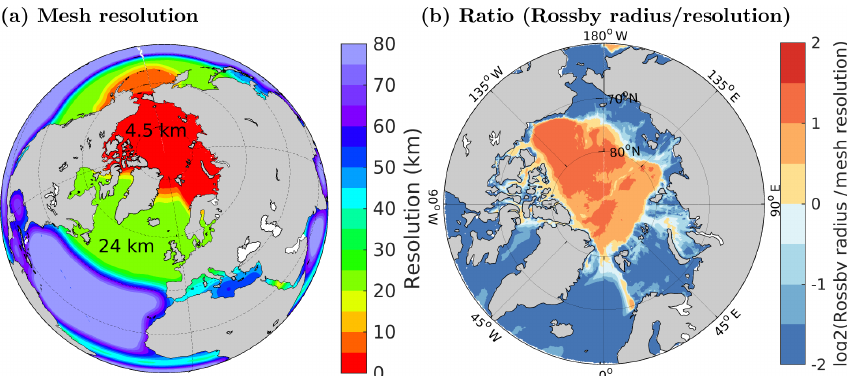
Figure 2. (a) The horizontal grid size of a mesh with 4.5km in the Arctic Ocean (referred to as mesh HIGH in this paper). (b) Ratio between the first baroclinic Rossby radius and grid size shown with the log2 scale for mesh HIGH. With resolution finer than two grid cells per Rossby radius, models may start to resolve mesoscale eddies depending on numerical mixing in the model. The Rossby radius is calculated for each season and the local minimum is used for panel (b)